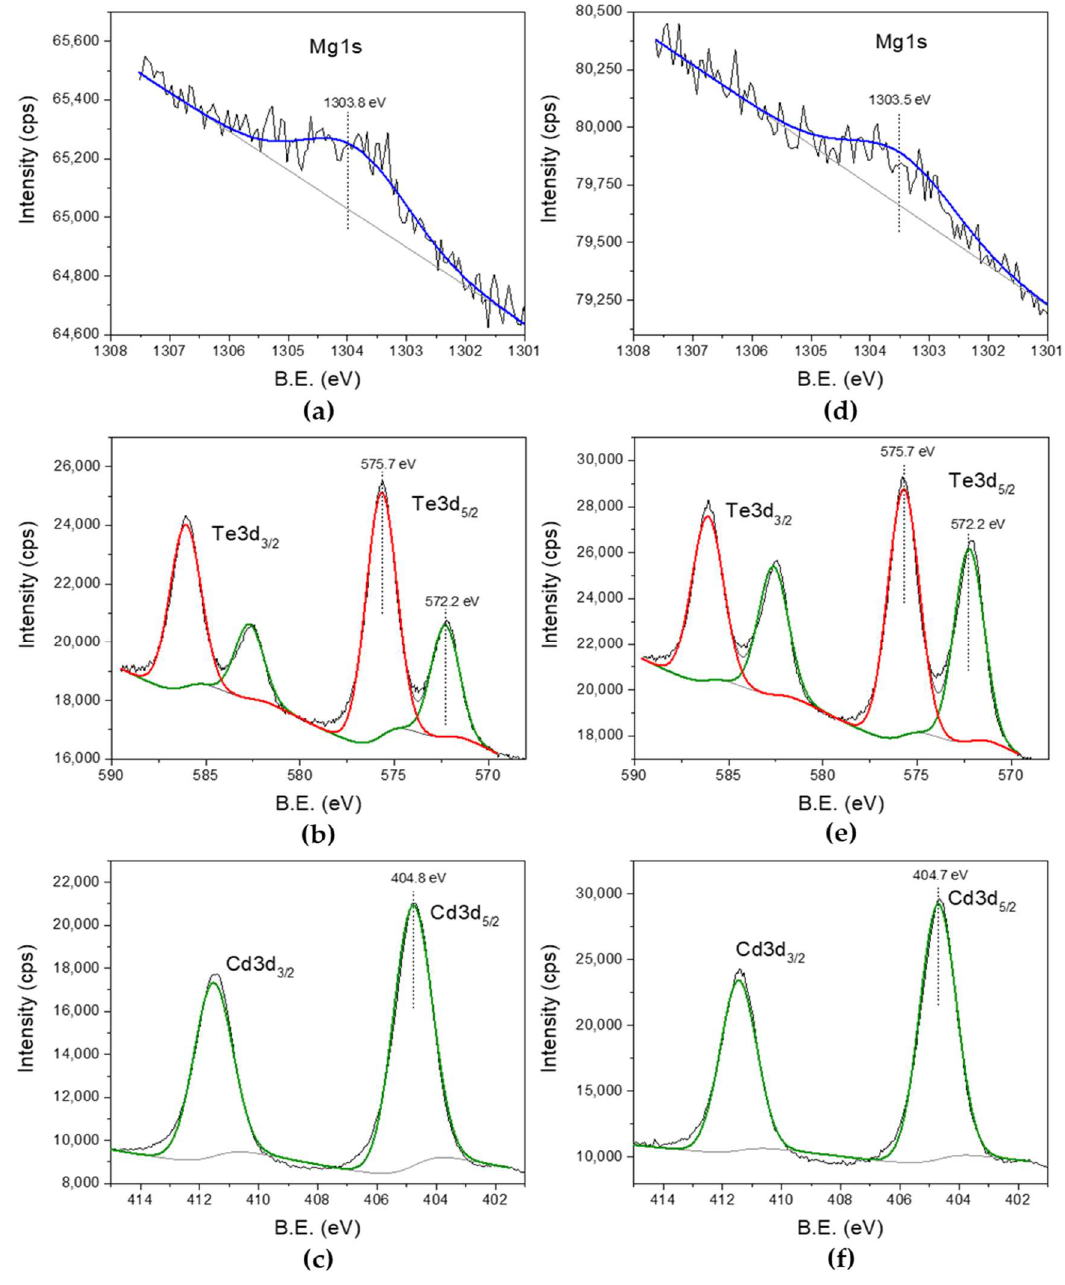
Figure 3. High-resolution XPS spectra of Mg1s, Te3d, and Cd3d for as-deposited ( a–c ) and heat-treated ( d–f ) layers grown at 1400 mV with high Mg presence in the bath.